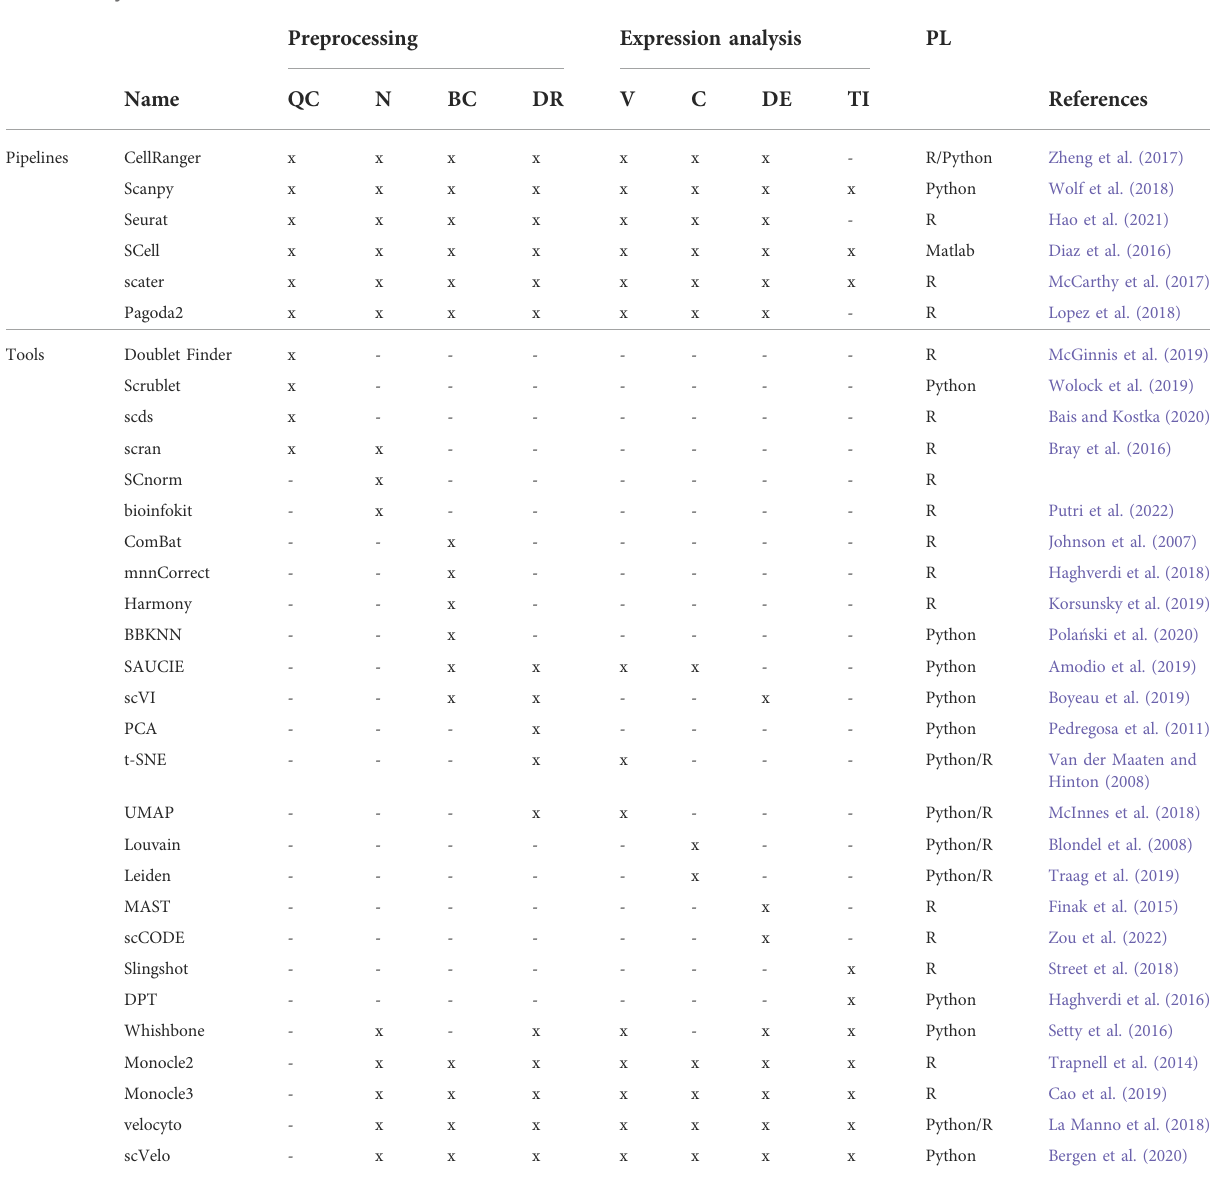
TABLE 2 Analysis